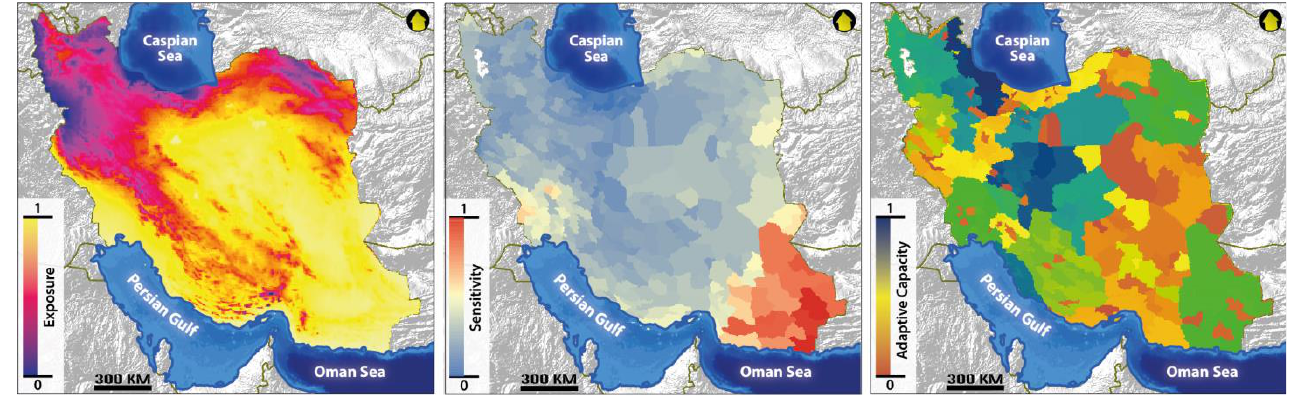
Figure 4. Components of sand and dust storm vulnerability assessment.